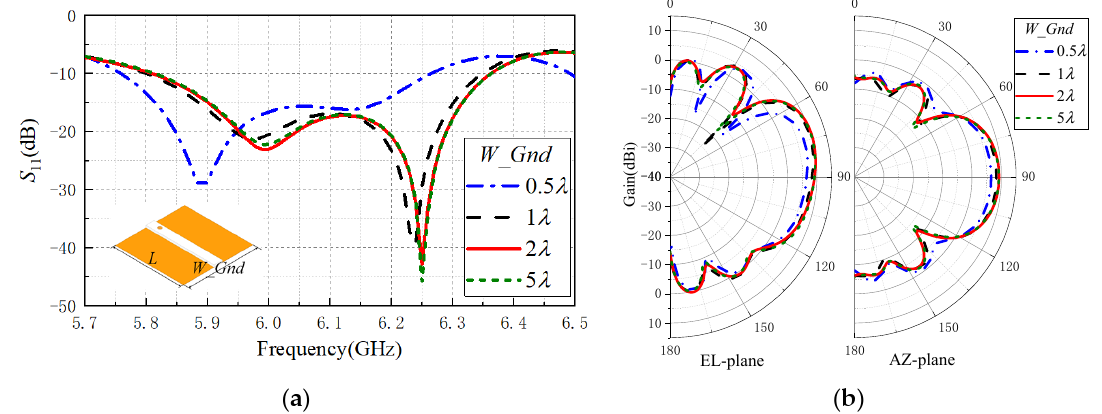
Figure 4. Performance of the proposed antenna with different widths of ground plane: ( a ) reflection coefficients, ( b ) radiation patterns.